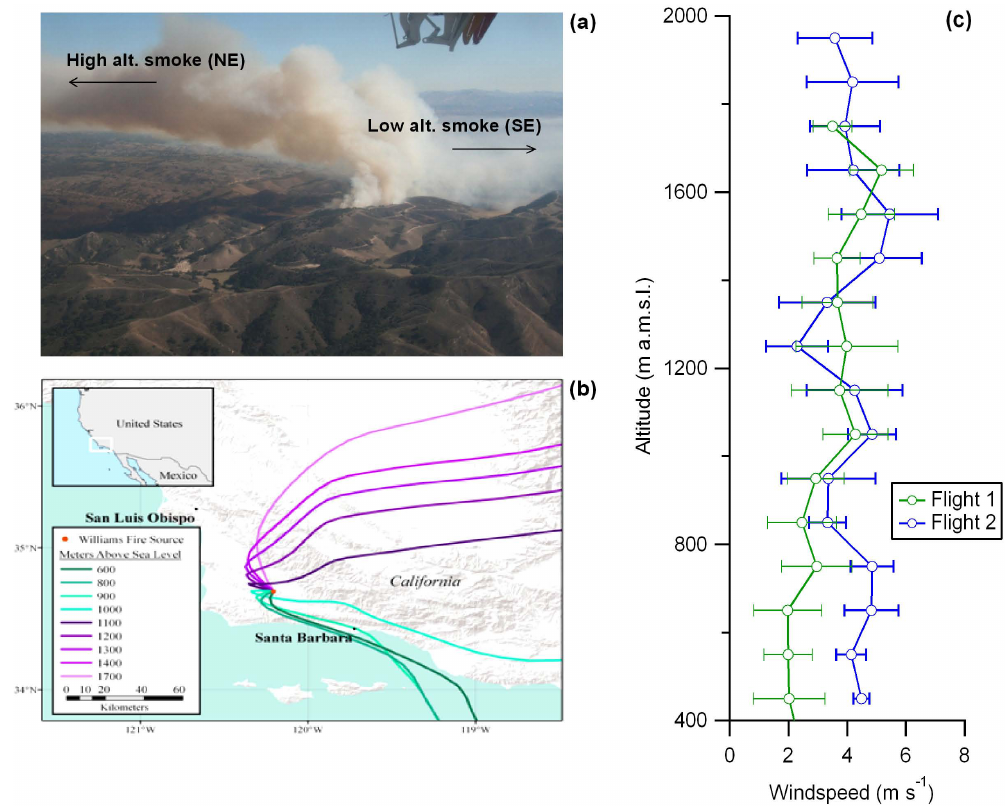
Fig. 1. (a) Photograph of the high- and low-altitude smoke plumes from the Williams Fire taken at 12:20LT on 17 November 2009 from the USFS Twin Otter. (b) HYSPLIT forward trajectories starting at 11:00LT at the Williams Fire (Draxler and Rolph, 2010; Rolph, 2010). Eight 24h trajectories show air at 600–1000ma.m.s.l. (green) drifting SE and air at 1100–1700ma.m.s.l. (purple) drifting NE. (c) Vertical profile of windspeeds from Flights 1 (green) and 2